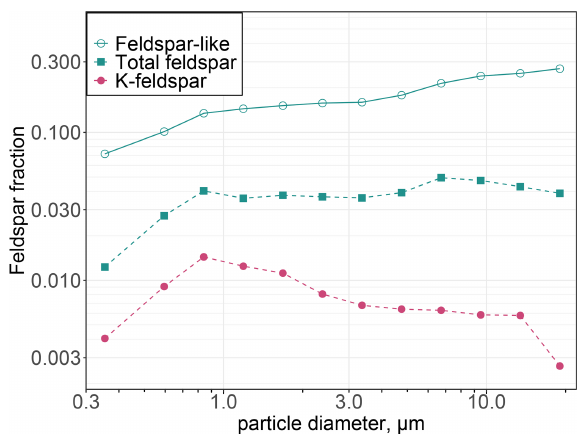
Figure 10. Mass ratio of feldspar-like particles, total feldspar (more strict criterion), and K-feldspar (more strict criterion) to total parti- cles.